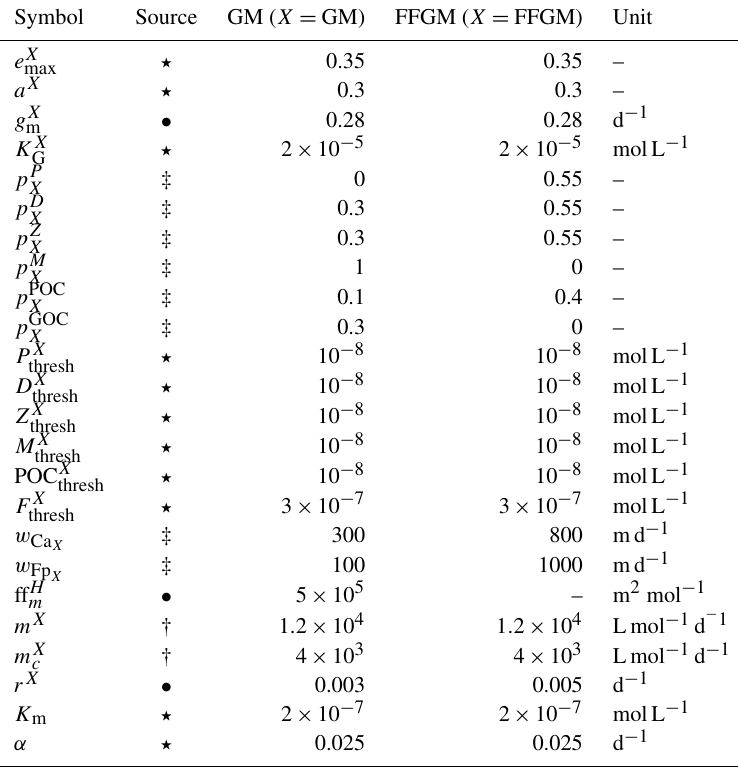
Table 2. Parameter values used in PISCES-FFGM. The symbols in the “Source” column indicate how the parameter value was determined: ( (cid:63) ) indicates parameters for which we assumed that both GM and FFGM share the same characteristics as mesozooplankton; ( • ) indicates metabolic rates assumed to vary with size, thus scaled using an allometric scaling conversion of mesozooplankton value based on (Hansen et al., 1997); (†) indicates parameters tuned to fit PISCES-v2 general biology dynamics; and (‡) indicates parameters whose values have been arbitrarily set based on information available in the literature and/or from the authors